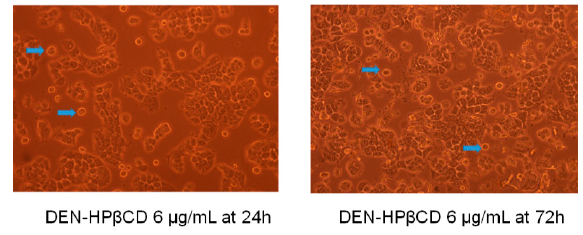
Figure 3. The morphological changes of HT29 treated cells with (3.125 and 6.25 µg/mL) of DEN- HP β CD complex for 24 and 72 h, Note: blue arrows indicate apoptotic cells (200×).